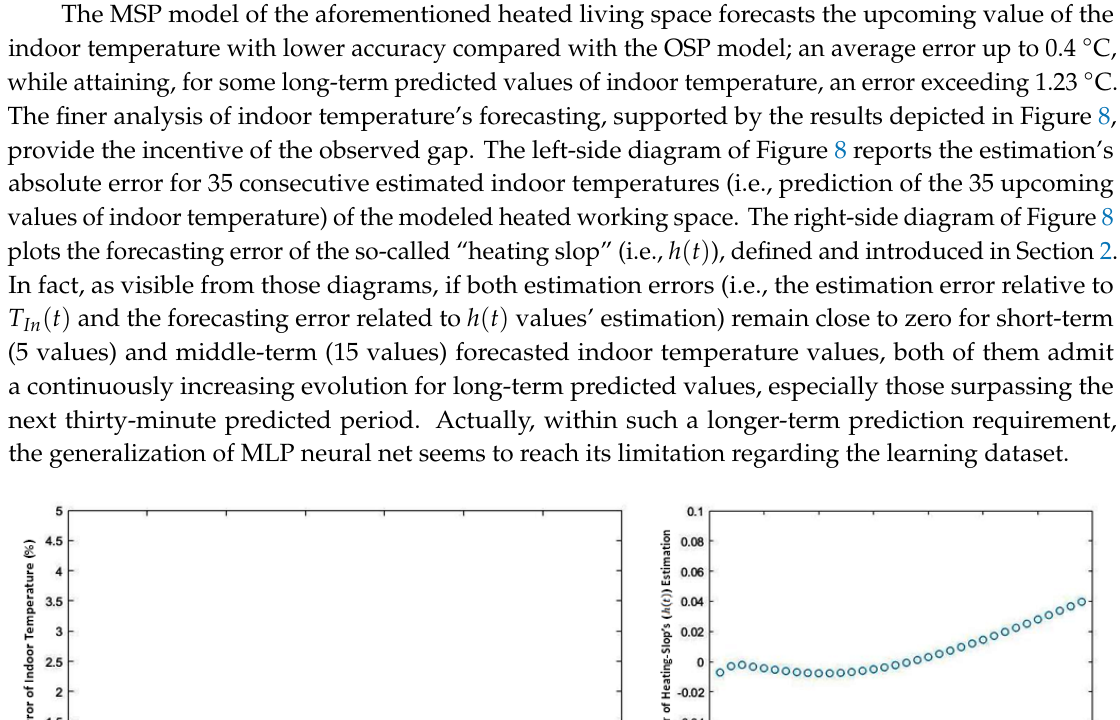
Figure 9. Heating slop when the living space is empty and when it is fully occupied.